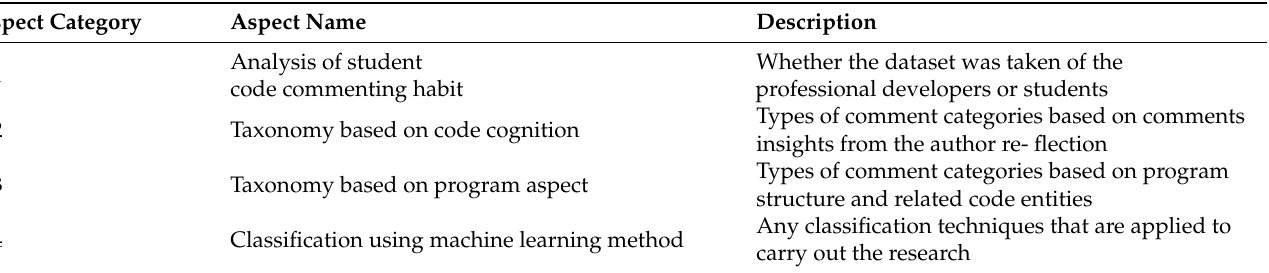
Table 1. Aspects considered in research.